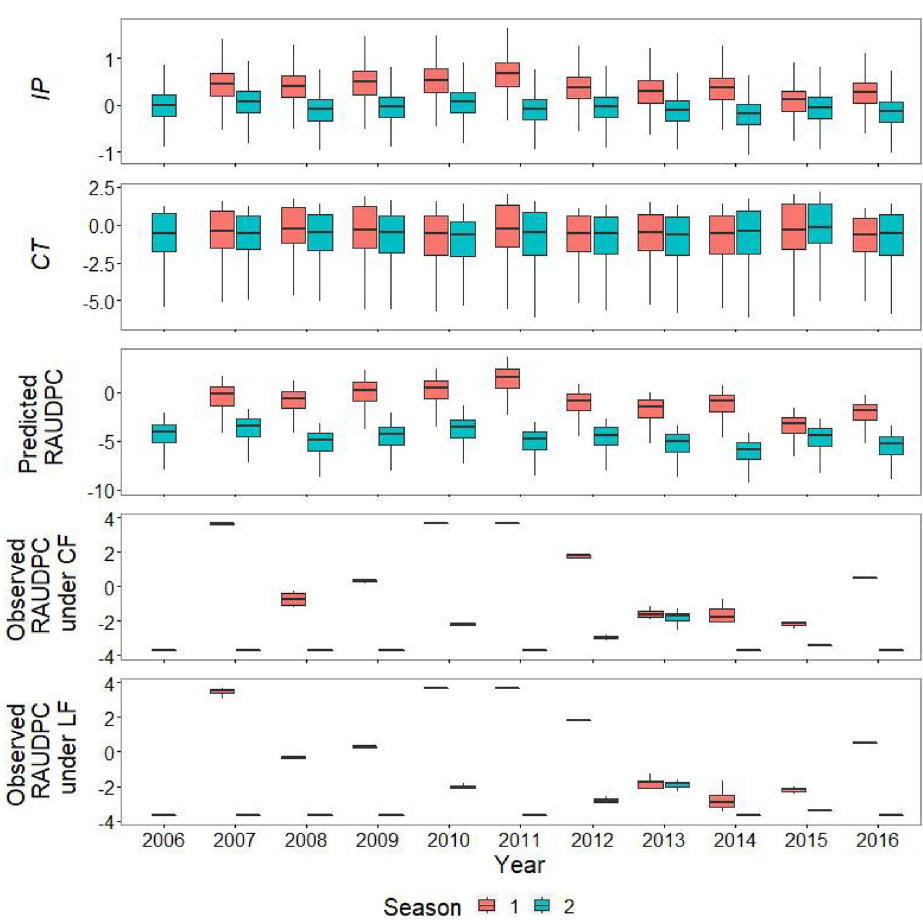
Figure 3. The progress rate of the development of primary inoculum ( IP ), the net catchment of the airborne spores by rainfall and wind onto the leaf area ( CT ; when subtracting the detachment of spores by rainfall from the host tissue) , and the predicted value of the relative area under the disease progress curve ( RAUDPC ) for rice blast and the observed RAUDPC for rice blast under conventional and low-external-input farming (CF and LF, respectively) from 2006 to 2016 in the rice fields of central Taiwan. Growing seasons 1 and 2 occur in the first and second halves of the year, respectively. All values of each variable were